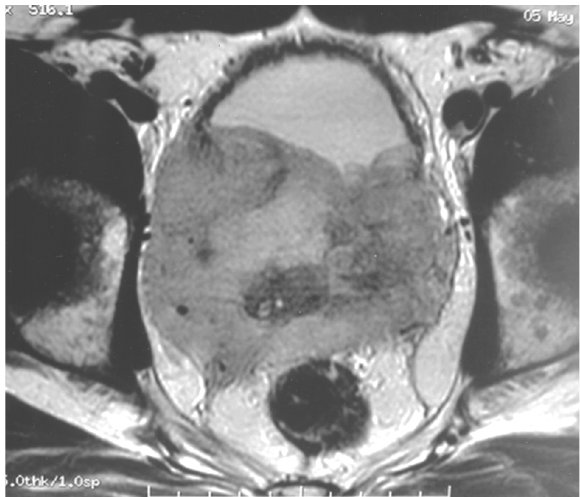
Figure 1 – Magnetic resonance imaging of pelvis, showing a voluminous expansive and infiltrative lesion in